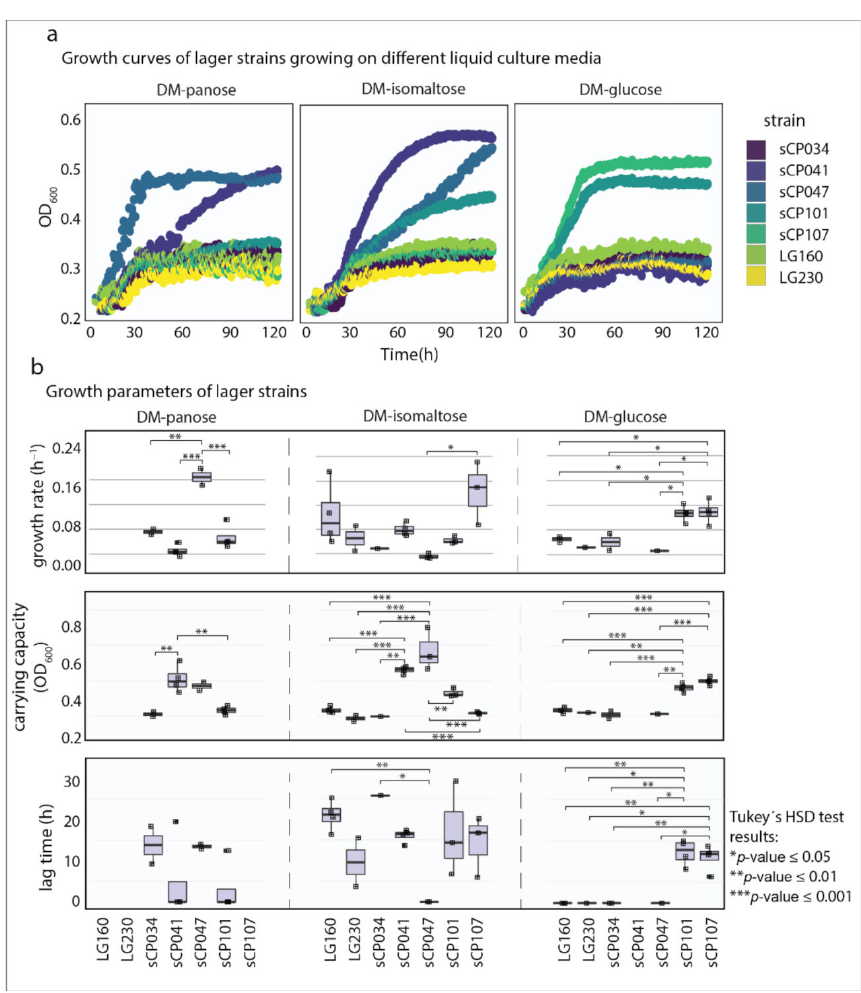
Figure 2. Phenotypic characterization of the engineered and parental lager strains on three different culture media. ( a ) The parental (LG160 and LG230) and engineered strains (sCP034, sCP041, sCP047, sCP101, and sCP107) were cultivated in three different culture media (DM-panose, DM-isomaltose, and DM-glucose) at 20 ◦ C for five days under continuous agitation, and their growth was measured by optical density at a wavelength of 600 nm using a Bioscreen C MBR (Oy Growth Curves Ab Ltd., Turku, Finland). ( b ) The growth parameters were estimated using the growthrates v0.8.2 [59] R package, specifically by the parametric growth model Baranyi–Roberts [60]. Only fitted curves with r 2 > 0.9 were considered. * indicates a statistically significant difference among the mean values of the growth parameters of two samples with a p -value ≤ 0.05; ** indicates a p -value ≤ 0.01; and *** indicates a p -value ≤